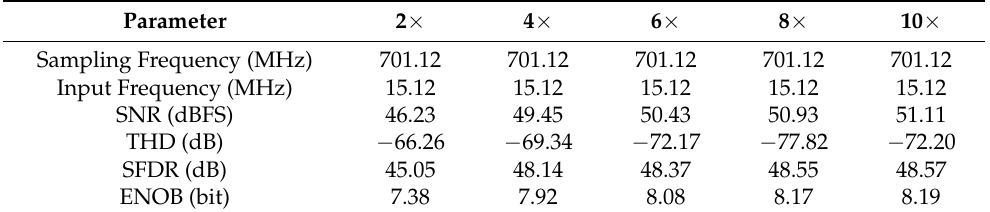
Table 2. Performance comparison of different interpolation multipliers under default filter parameters.